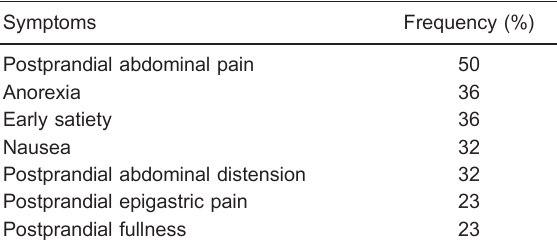
Table 2. Dyspeptic symptoms reported by 21 of the 22 patients studied (1 patient did not report any symptoms).